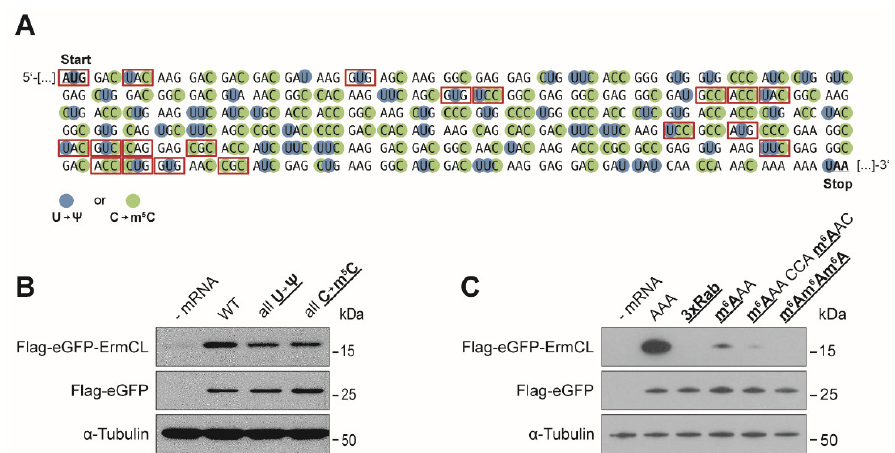
Figure 2. Translation efficiency and accuracy of multiple modified mRNA nucleotides. ( A ) Sequence of the reporter eGFP mRNA is depicted. Employing in vitro transcription, the Us and Cs were substituted with Ψ s and m 5 Cs, respectively. The respective Cs are depicted in green and the Us in blue. The amino acids corresponding to selected codons (red boxes) were analyzed by mass spectrometry for their identity (detection limit ~1%). ( B ) Western blot analysis of the translation products derived from mRNAs carrying multiple Ψ s or m 5 Cs. ( C ) Western blot analysis of translation products harboring one, two or three m 6